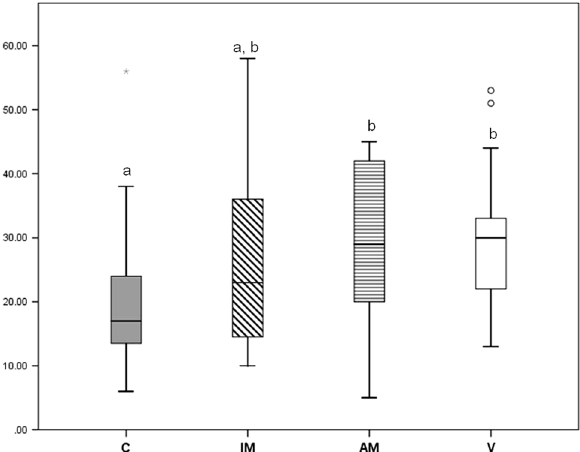
Figure 2. Comparison (median, interquartile range) of male searching behaviour on silk extracts from unmated females (V) (white box, n = 23), adult mated females (AM) (horizontal striped box, n = 16), immature mated females (IM) (diagonal striped box, n = 23), and control (methanol, C) (gray box, n = 23). Different letters above box plots show significantly different outcomes (p < 0.05, post-hoc test).